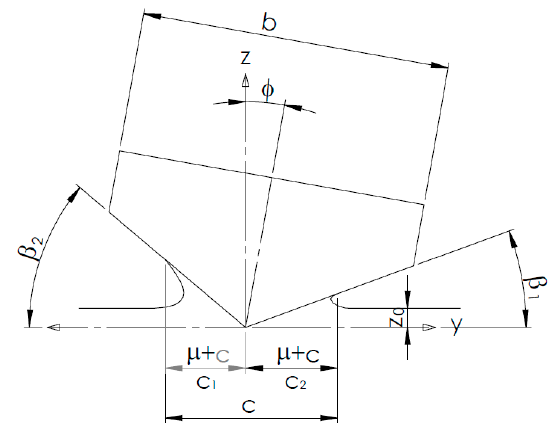
Figure 2. Impact with asymmetry entry.